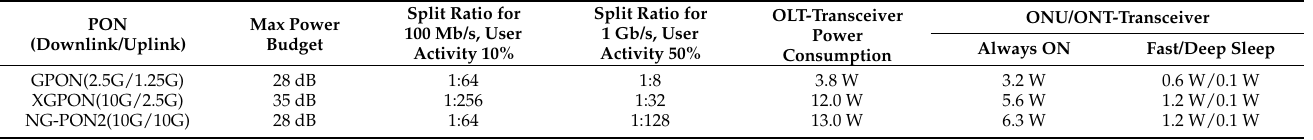
Figure 10. ONU/ONT Energy Consumption (basic modes) in arbitrary units.